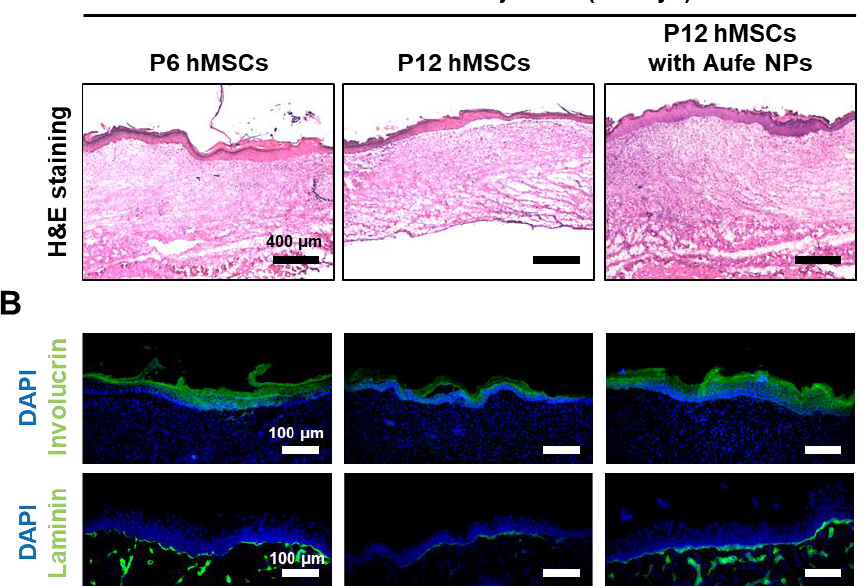
Figure 5. ( A ) Hematoxylin and eosin-stained sections of the mid-portion of the wound at 14 days after treatment. Scale bars represent 400 µm. ( B ) Immunohistochemical staining of involucrin (green) in the epidermis and laminin (green) in the basal layer along with 4′,6-diamidino-2-phenylindole (DAPI) (blue) staining in the healing wound at 14 days after treatment. Scale bars represent 100 µm.